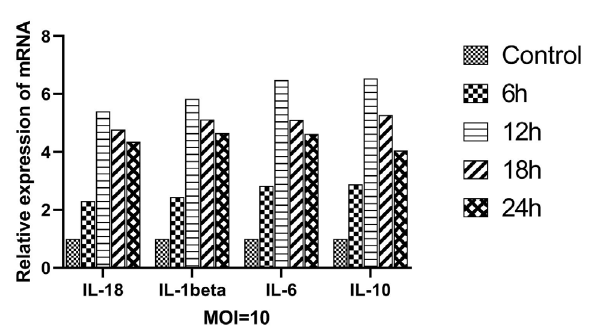
Fig. 1 . Effect of S.suis2 infection on the expression of cytokines (MOI = 1)